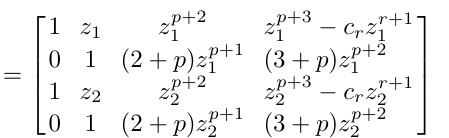
Fig. 2. Finite element model of rotating tapered Timoshenko